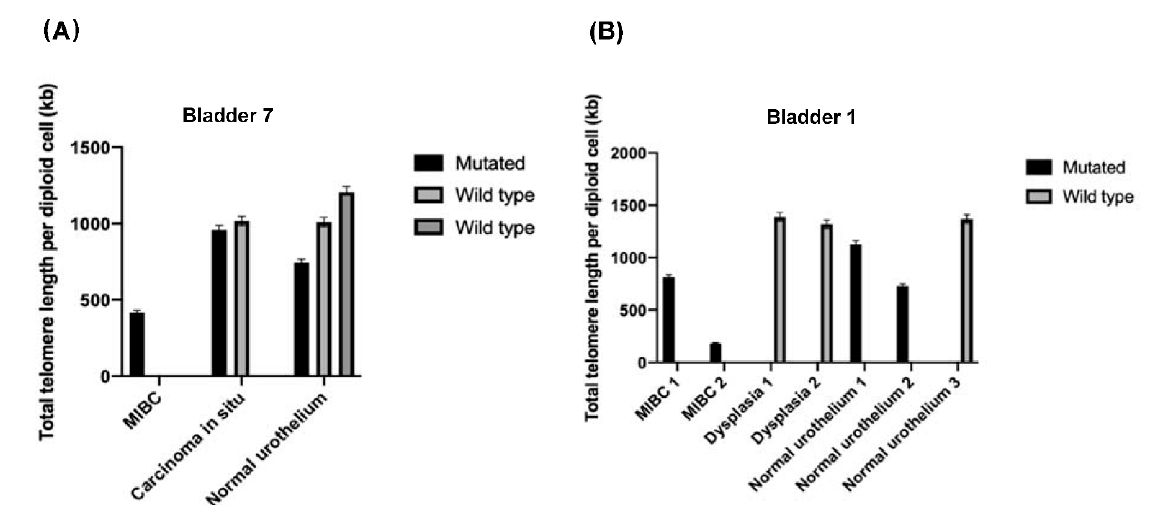
Figure 3. ( A ) Bladder 7 tissue specimens from the whole-organ mapping bladder specimen and amount of the total telomere length. ( B ) Same presentation for Bladder 1 .